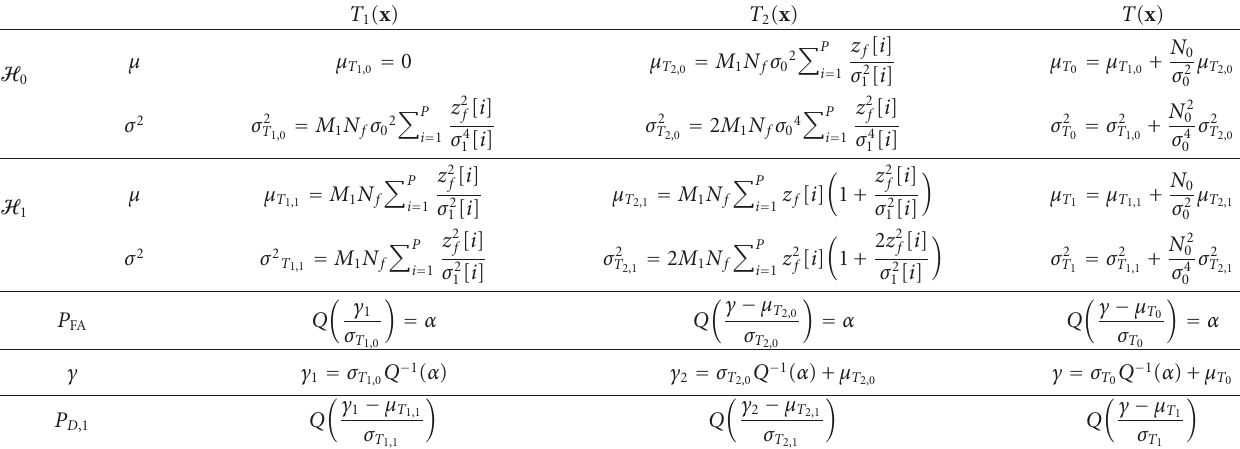
Table 1: Statistical Analysis and Performance Evaluation for Di ff erent Detectors, P > 1, T sam = T f